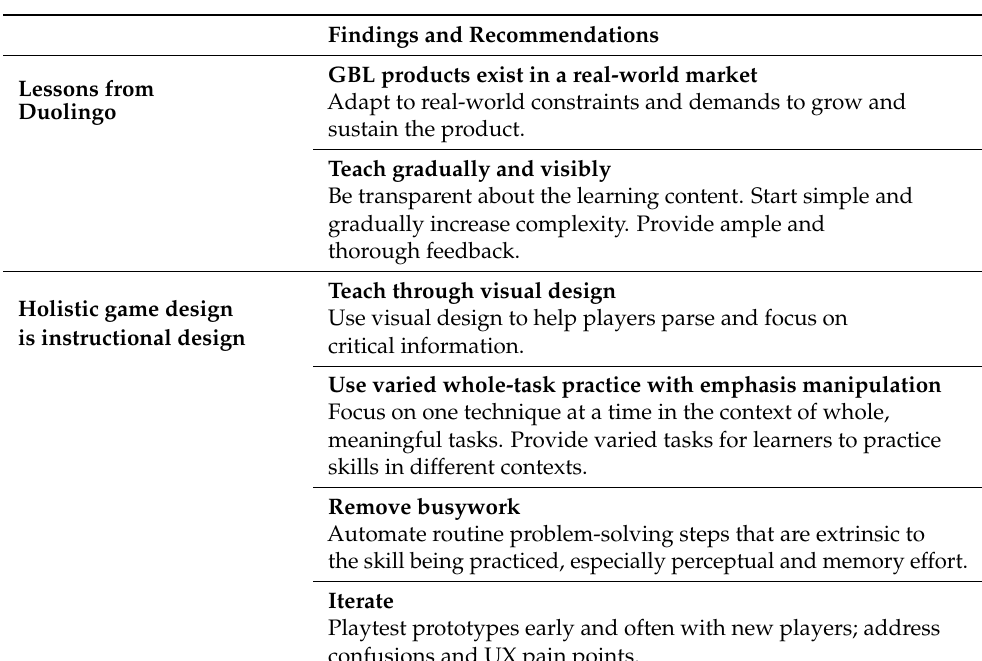
Table 1. A summary of findings and recommendations from the thematic analysis of case studies in complex